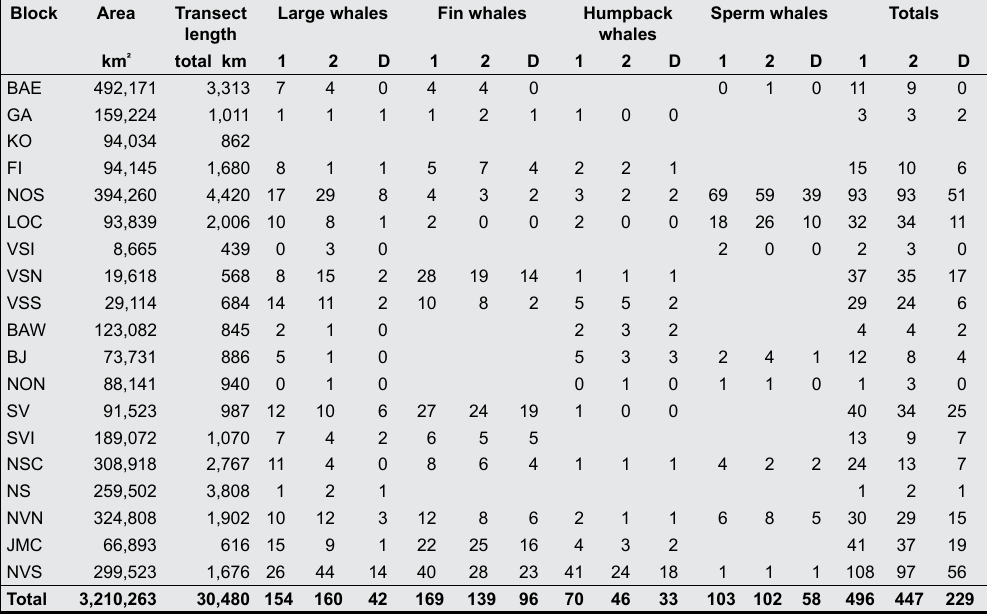
Table 3. Area, transect lengths and distribution of primary sightings by block and species, 1996-2001. The headings ‘1’ and ‘2’ means number of sightings from upper and lower platform, respectively; ‘D’ are judged duplicates between platforms 1 and 2. In addition there are a few sightings of sei whales (5 from both platforms, blocks NVN and JMC, no duplicates), and of blue whales (10 sightings in all, blocks NVN, JMC, SV and SVI, 2 duplicates).